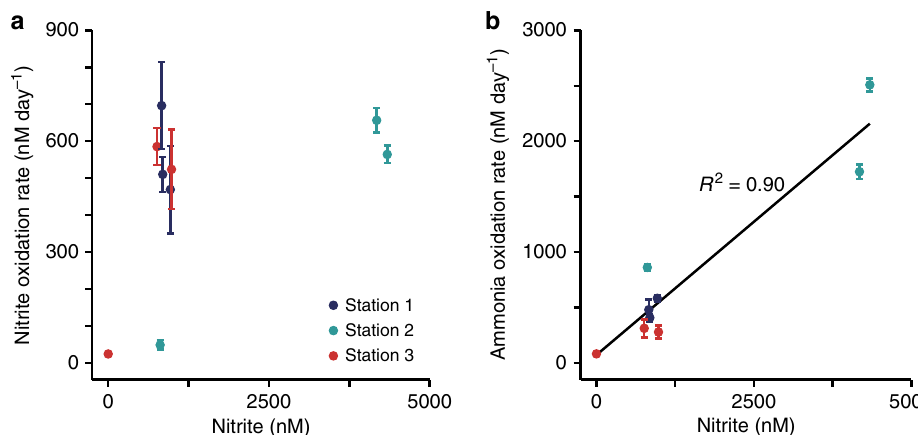
Fig. 2 Correlations between nitrite and ammonia oxidation rates and nitrite concentrations across investigated stations. a Correlation between nitrite oxidation rate and nitrite concentration. b Correlation between ammonia oxidation rate and nitrite concentration (reproduced from ref. 31 ). The black line is the linear regression, R 2 was calculated on the basis of Pearson correlations, and was signi fi cant (two-sided t -test, t = 8.002, DF = 7, P = 9.10 × 10 − 5 ). Error bars represent standard error of the process rates calculated from slopes across all time points and